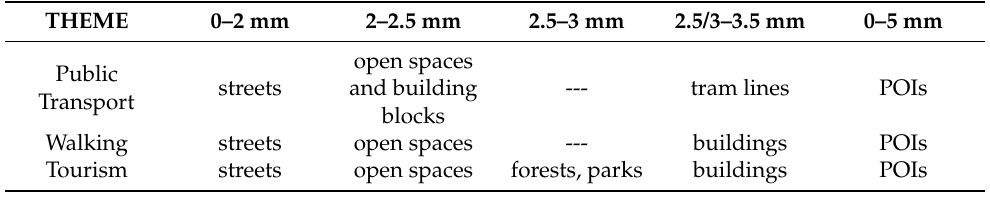
Table 1. Height ranges of individual layers for all three map types.